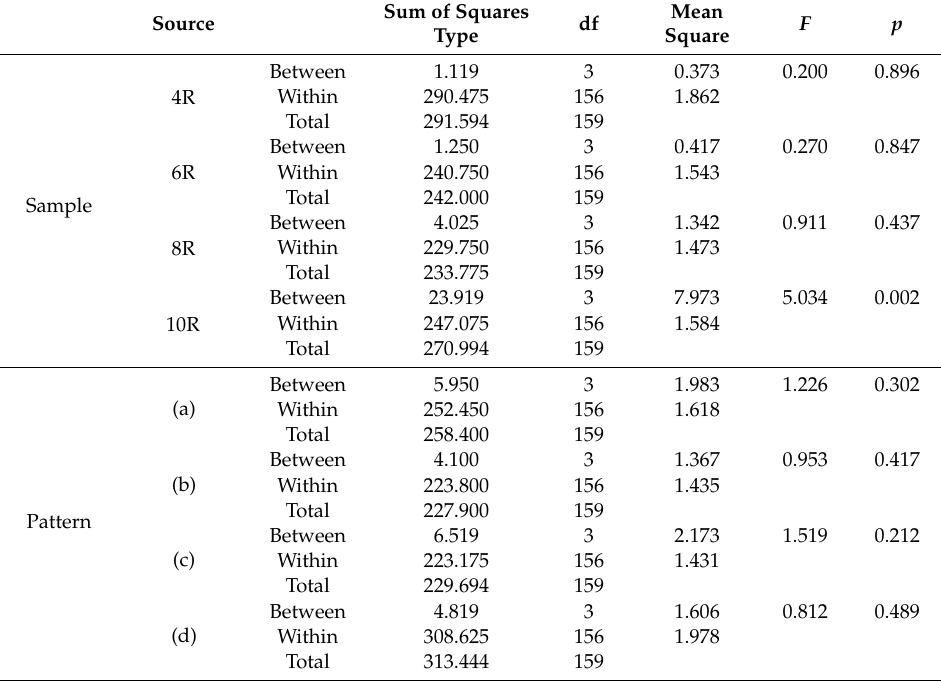
Table 10. Results of one-way ANOVA for stability by each sample and usage pattern.